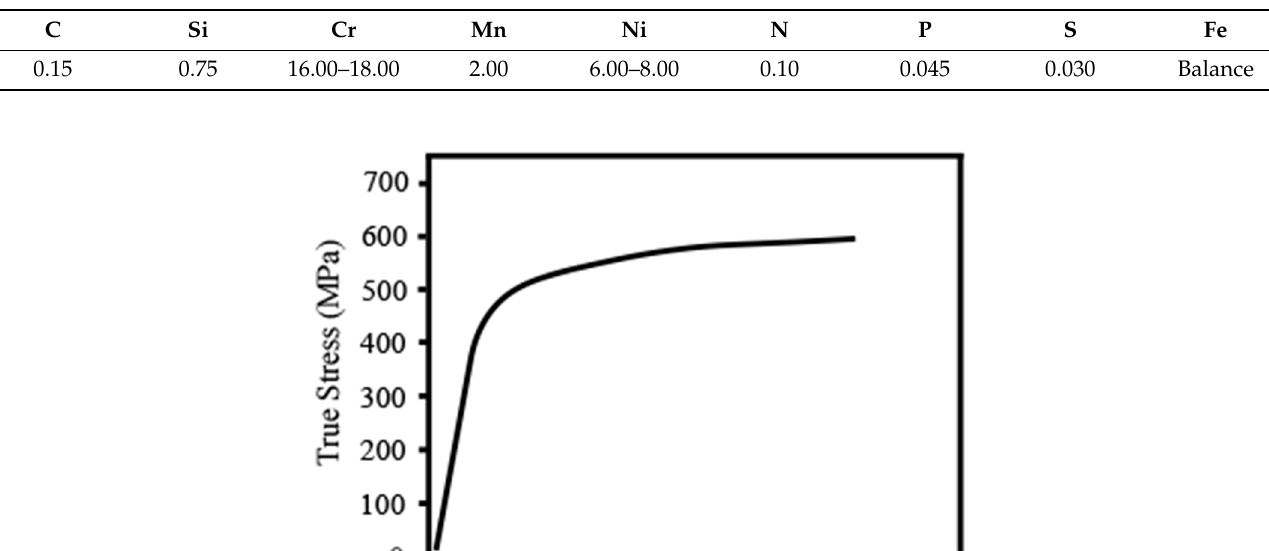
Figure 1. Stress-strain curve of annealed SUS301 foils from micro tensile tests. Table 1. Chemical compositions of SUS301 (wt%).